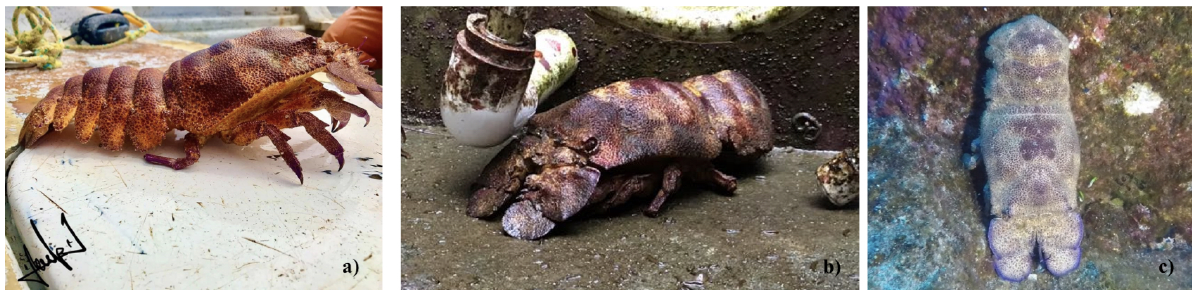
Figure 1. Adult specimens of Scyllarides astori , taken at Guadalupe Island ( a ), Natividad Island ( b ) and Socorro Island ( c ) (photographs taken by Javier González, Ramon Martínez/Elba López and Arturo